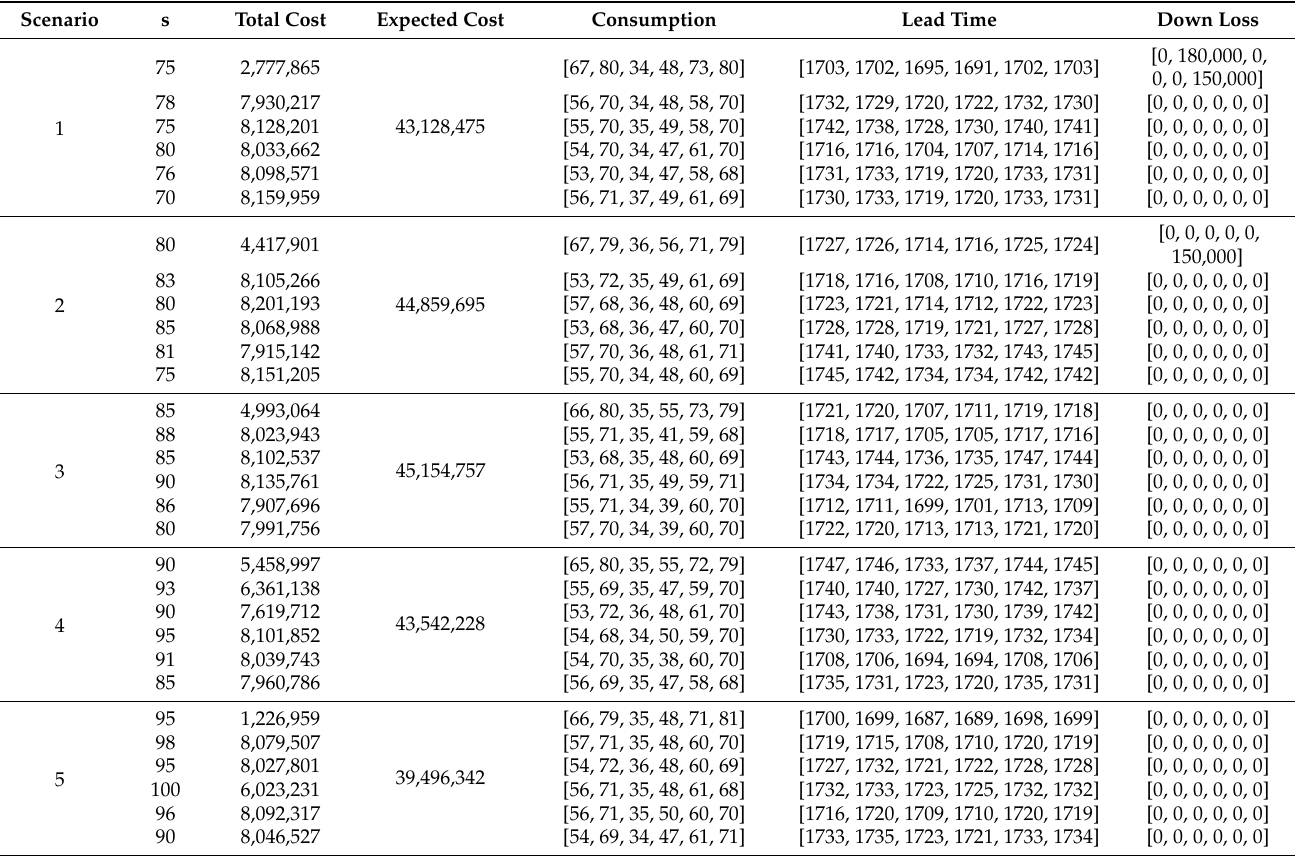
Table A7. Results for maximum stock